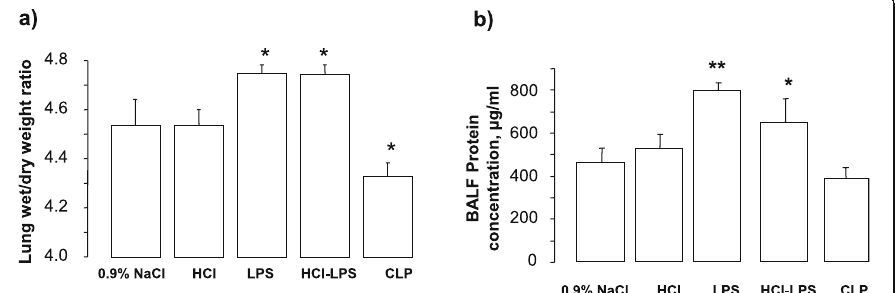
Fig. 3 Lung edema, quantified by the a wet/dry weight ratio and b total proteins from bronchoalveolar lavage fluid. Data are presented as mean ± SEM. Wet/dry weight ratio, LPS: *** p < 0.0001 vs 0.9% NaCl or HCl or CLP; HCl-LPS: ** p < 0.005 vs 0.9% NaCl or HCl; total proteins, 24 h, LPS: ** p < 0.01 vs 0.9% NaCl or HCl or CLP; HCl-LPS: * p < 0.05 vs 0.9% NaCl or